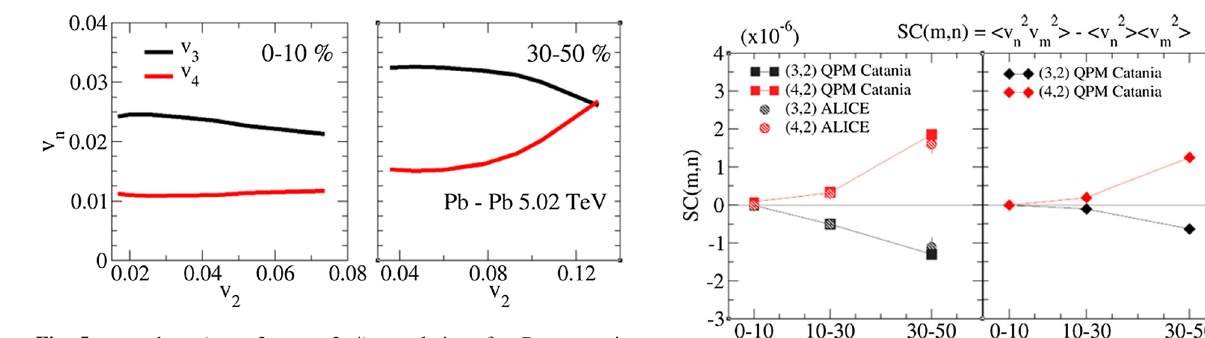
Fig. 5 v n and v m ( n = 2 , m = 3 , 4) correlations for D mesons in √ PbPb collisions at s NN = 5 . 02 TeV for both 0–0% (left panel) and 30-50% (right panel) centrality class Fig. 6 Symmetric cumulant correlator SC ( m , n ) for both charged par- ticles(leftpanel)andpredictionfor D mesons(rightpanel)asafunction of centrality class. In the left panel the experimental data taken from ALICE Collaboration